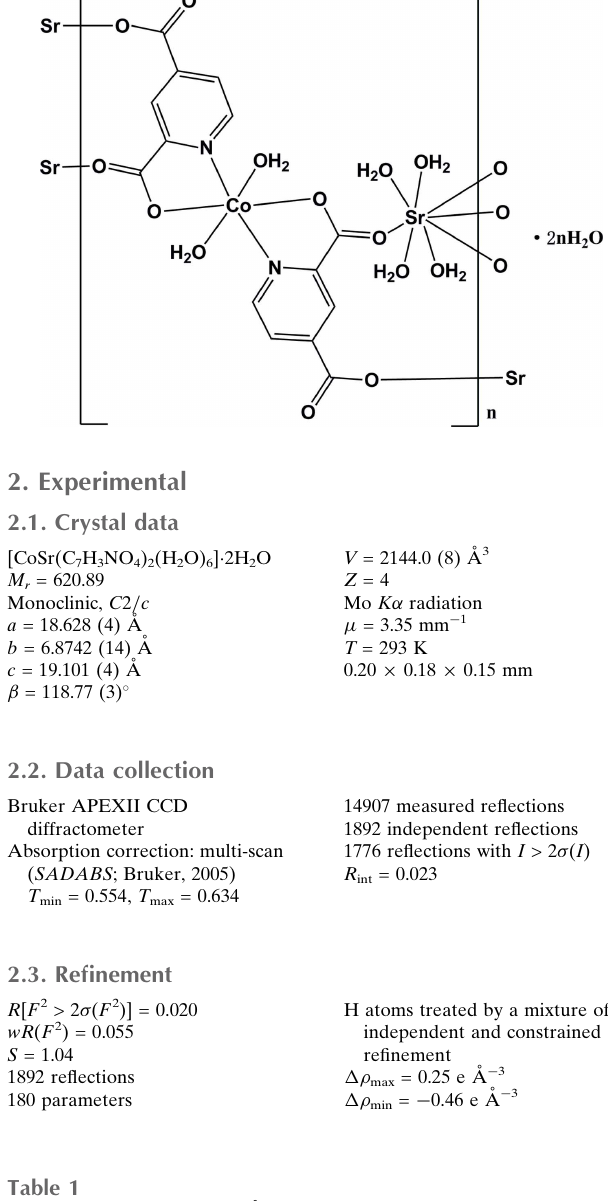
Hydrogen-bond geometry (A˚ , (cid:4)